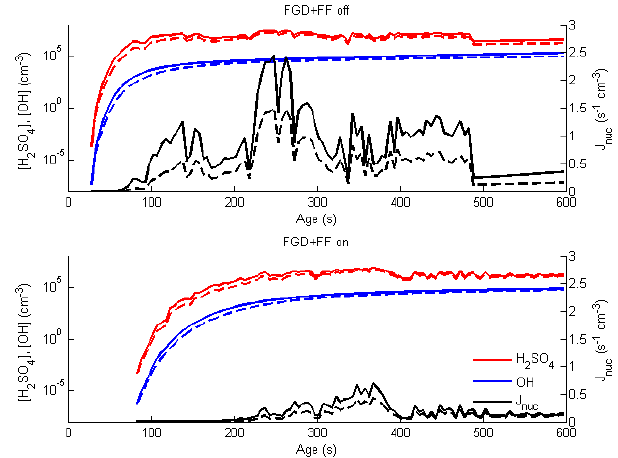
Figure 5. Time development of [H 2 SO 4 ] (red lines), nucleation rate (black lines), [OH] (blue lines) (cm − 3 ). Dashed and dotted red lines correspond to model results for stability classes c and d (top panel) and b and c (bottom panel),